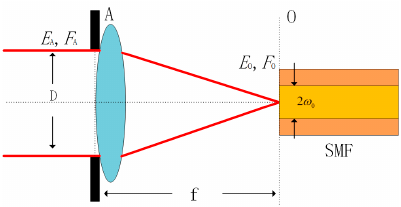
Figure 1. Scheme of spatial light coupling into a single-mode fiber (SMF).